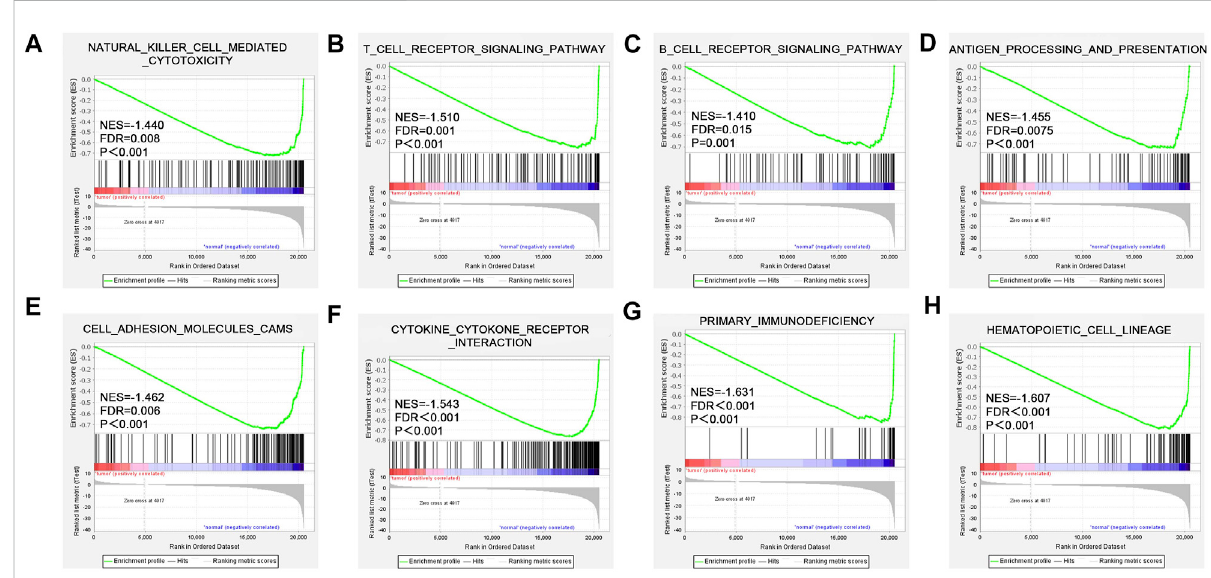
FIGURE 4 Enriched pathways of CD161 expression in BC analyzed by GSEA. Up-regulated genes located on the left approaching the origin of the coordinates,anddown-regulatedgeneslayontherightof x -axis.Onlygenesetswith p < 0.05andFDR < 0.05wereconsideredsigni fi cant.Topeight signi fi cant pathways associated with low CD161 expression were displayed in the plot. (A) NK cell-mediated cytotoxicity pathway, (B) T cell receptor signaling pathway, (C) B cell receptor signaling pathway, (D) antigen processing and presentation, (E) cell adhesion molecules cams, (F) cytokine-cytokine receptor interaction, (G) primary immunode fi ciency, (H) hematopoietic cell lineage. BC, breast cancer; GSEA, gene set enrichment analysis; NES, normalized enrichment score; FDR, false discovery